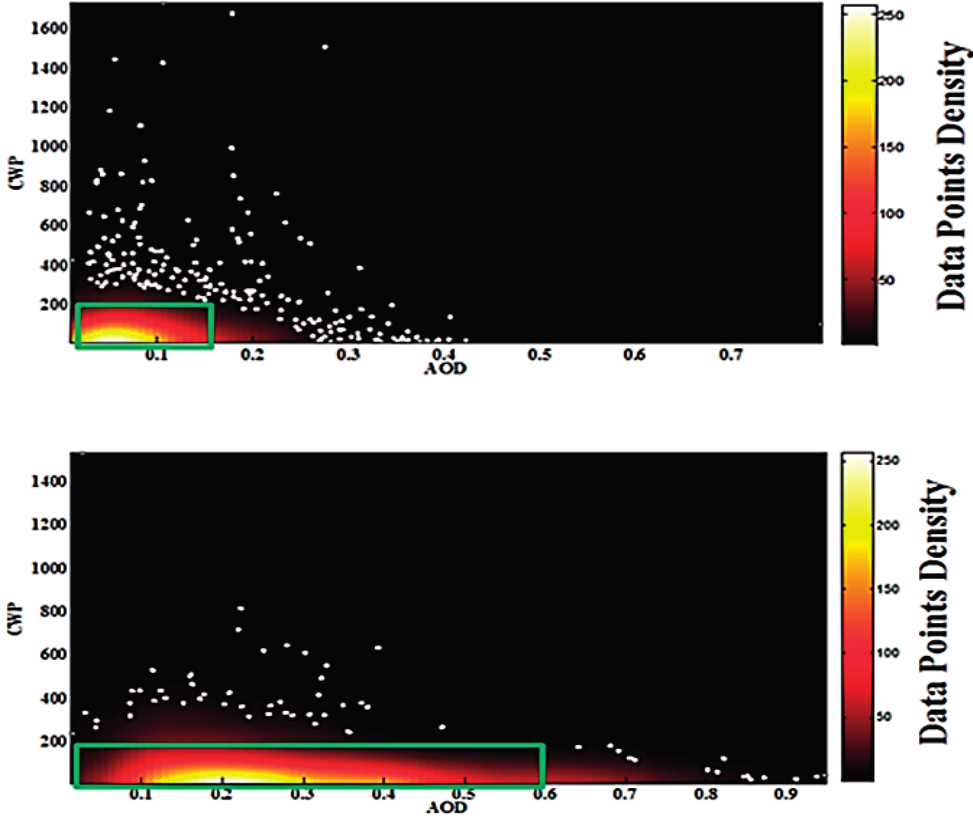
Figure 4. Data points’ density distribution in a cloud water path (CWP) vs. aerosol optical depth (AOD) plot for NAADR_Marine ( Top ) and NAADR_Land ( Bottom ). The green rectangle indicates the best ranges of AOD and CWP to obtain a minimum of 50 data points density per AOD bin (0.01) and (0.05), respectively, for NAADR_Marine and NAADR_Land. The range for AOD are [0, 0.15] & [0, 0.6] and CWP [0;